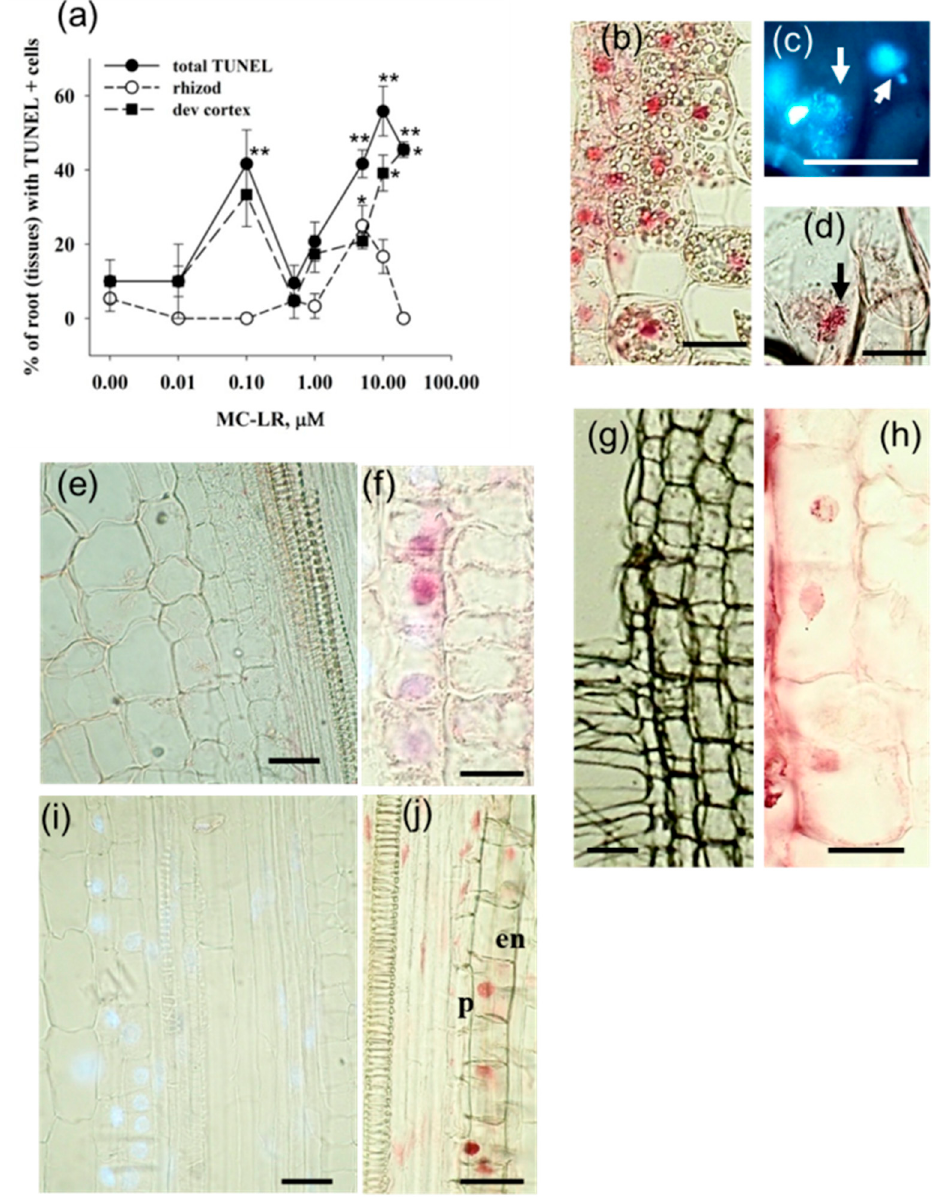
Figure 1. The effect of MC-LR on the induction of programmed cell death (PCD) in mustard roots exposed for 4 days to the cyanotoxin, as revealed by the TUNEL reaction in longitudinal sections. ( a ) The dose-dependent effects of MC-LR on the formation of TUNEL-positive cells and tissues (rhizod-rhizodermis/root epidermis; dev cortex: developing cortex tissue in the elongation and root hair zone). Significance of differences between controls and treated ones were evaluated by t -tests, Sigma-Plot 12.0; * p < 0.05; ** p < 0.001. ( b – d ): Root cortex cells from a root exposed to 20 µ M MC-LR: ( b ) TUNEL reaction; ( c ) Different stages of nucleus fragmentation (arrows); ( d ) TUNEL reaction of the highly fragmented nucleus (arrow). ( e ) General view of developing cortex and stele of a control root. ( f ) TUNEL-positive developing root cortex cells in a root treated with 1 μ M MC-LR. ( g ) Epidermis and outer cortex layers of a control root. ( h ) TUNEL-positive cells in the epidermis of a root treated with 5 μ M MC-LR. ( i ) Developing inner cortex and stele of a control root. ( j ) TUNEL-positive cells in the endodermis (en) and pericycle (p) of a root treated with 20 μ M MC-LR. Scalebars: 50 μ m.